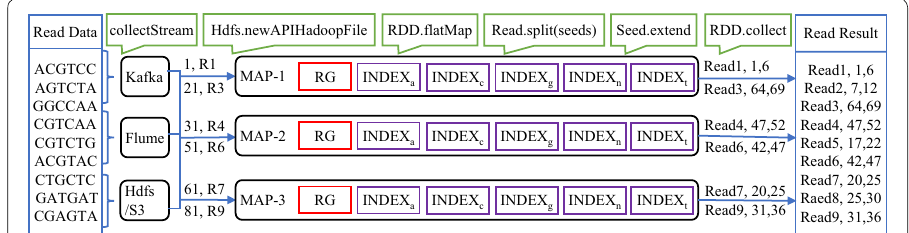
Fig. 6 Mapreduce architecture for Phase III (stream